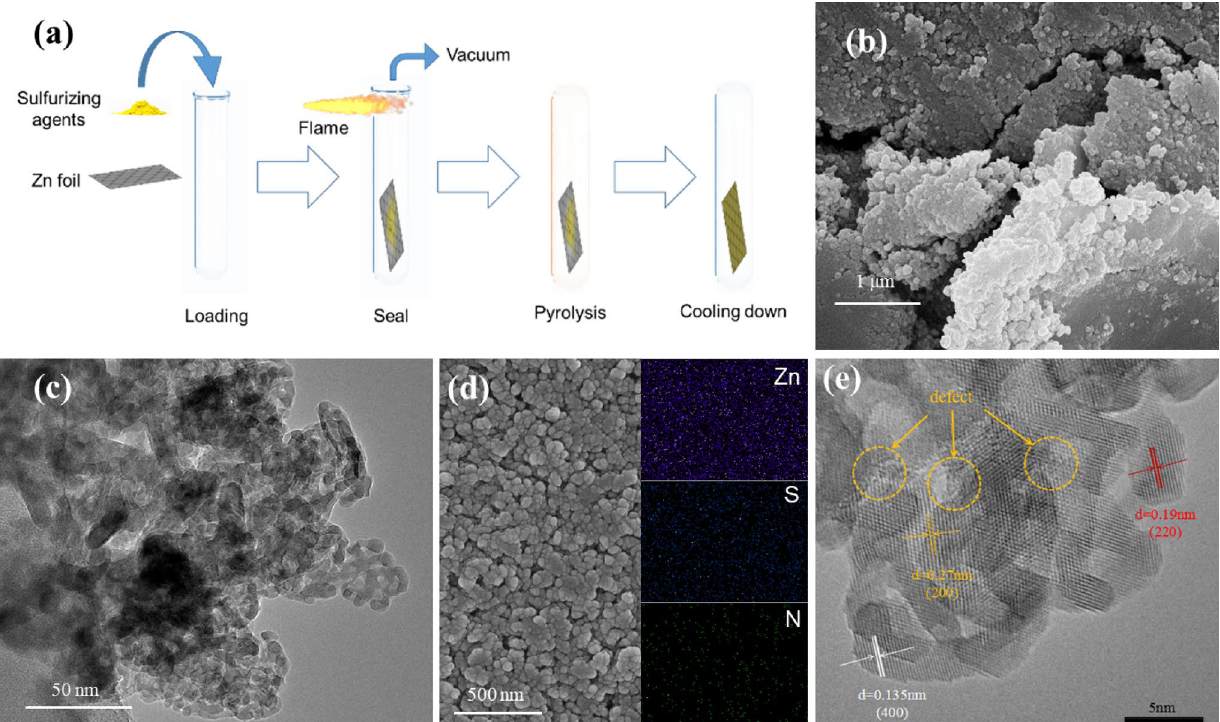
Fig. 1 Synthesis and characterization of catalysts. a Synthetic route for zinc sulfide materials using ampoule method. b SEM image of N@ZnS/Zn. c TEM image of N@ZnS/Zn. d SEM image of